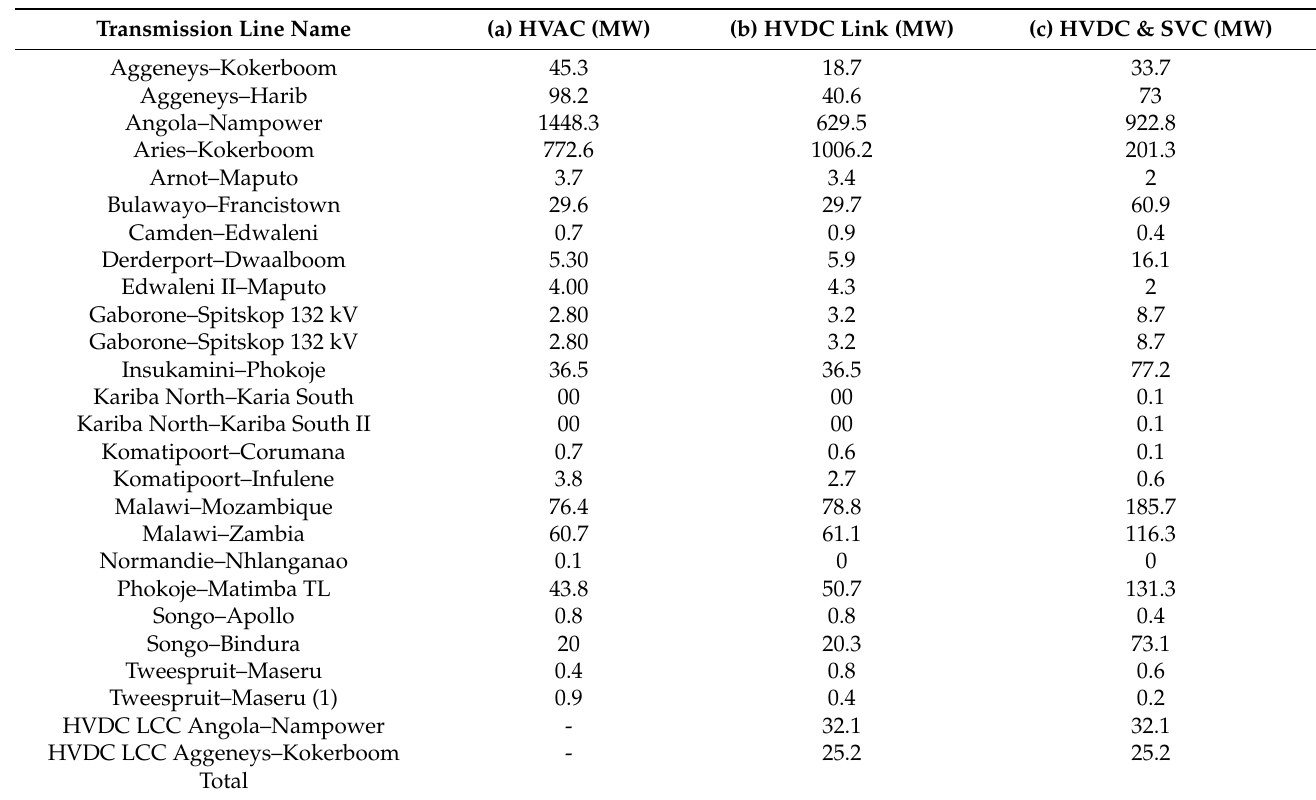
Table 6. Different transmission line loss profiles for the SARG